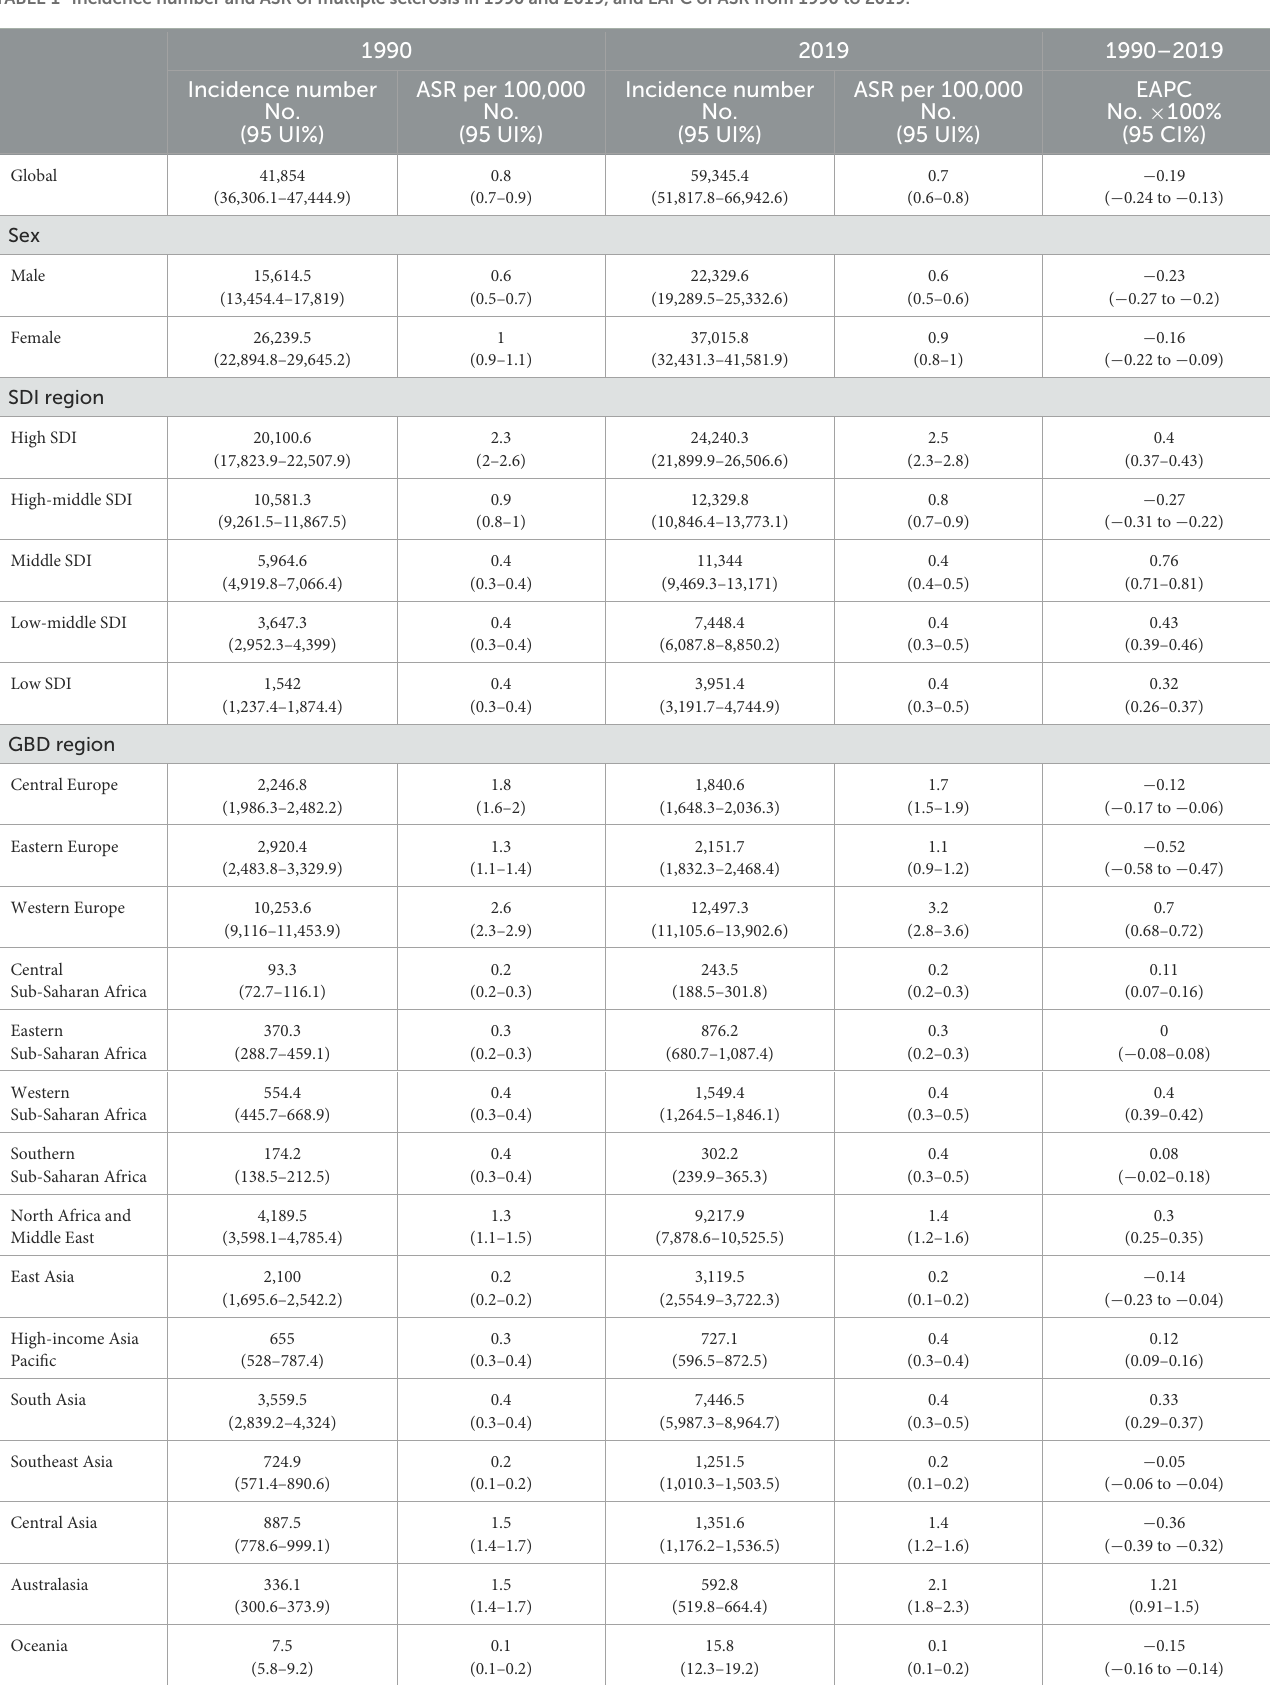
TABLE 1 Incidence number and ASR of multiple sclerosis in 1990 and 2019, and EAPC of ASR from 1990 to